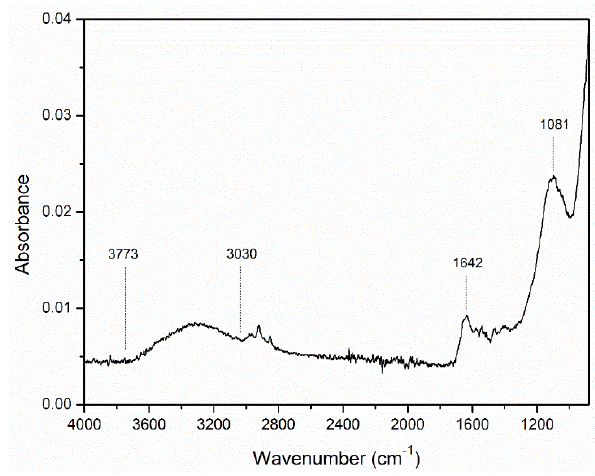
Figure 12. FTIR spectrum of the GHA100 / 100Cr6 samples wear track.